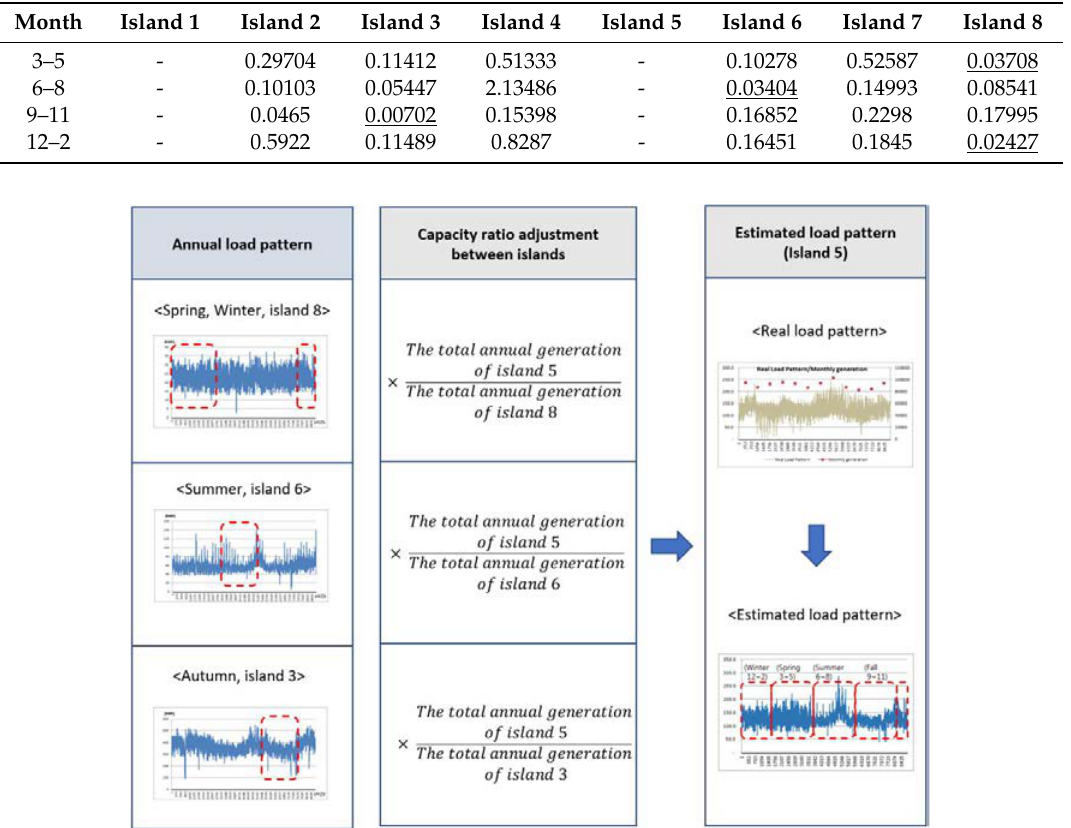
Figure 7. Estimation process for load pattern by season.